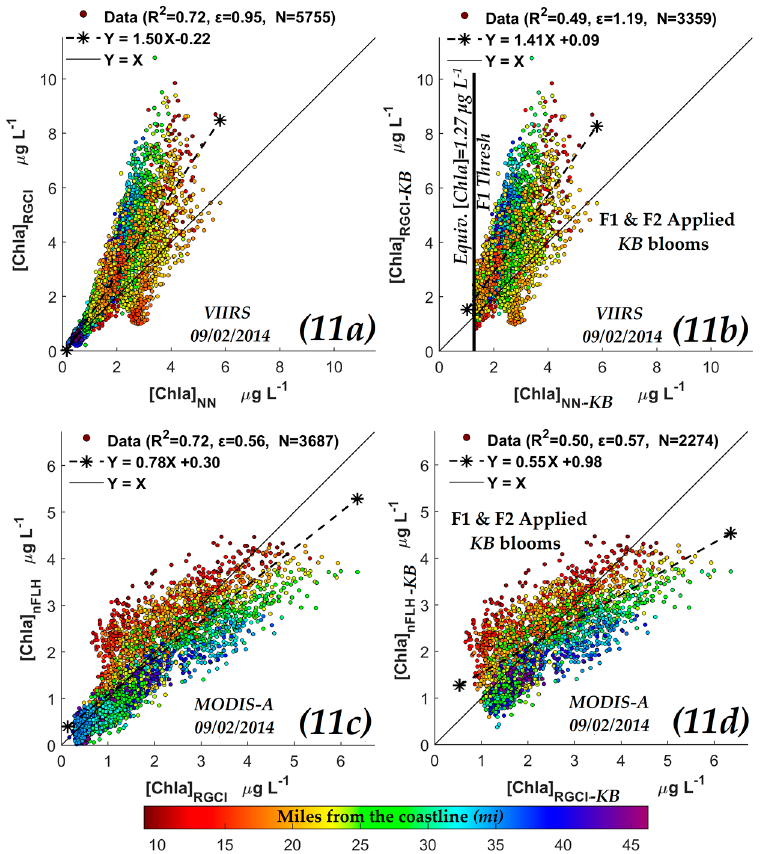
Figure 11. ( a ) Retrieved VIIRS RGCI [ Chla ] against retrieved VIIRS NN [ Chla ]; ( b ) Same retrieval as 11a with Filters F1 and F2 applied; ( c ) Retrieved RGCI [ Chla ] against MODIS-A nFLH equiv. [ Chla ]; ( d ) Same as 11c but with filter F1 & F2 applied. The vertical line shows the NN [ Chla ] KB threshold (F2 mask) Color coding of the dots denotes distance to shore, with red being the closest.